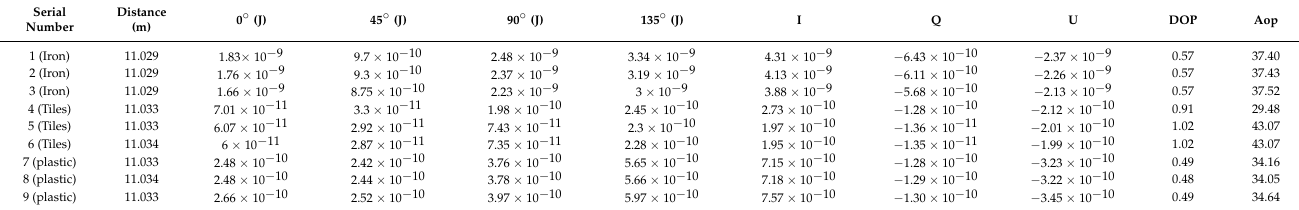
Figure 4. Experimental setup for measuring polarization characteristics in air. Table 2. Test raw data after reflection of different targets in the air.